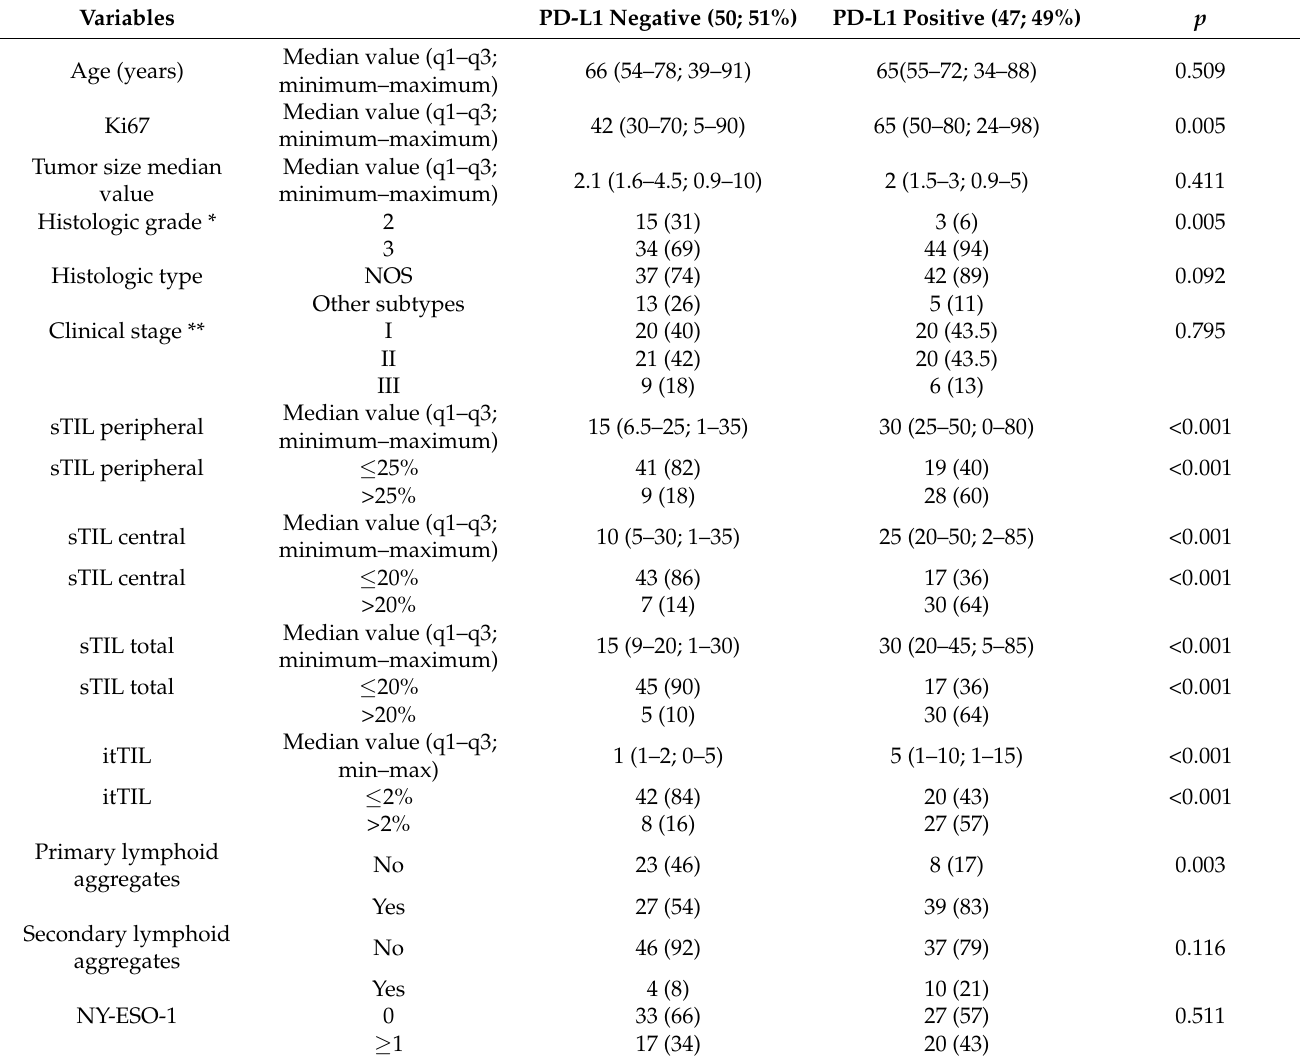
Table 2. Association of studied variables with PD-L1